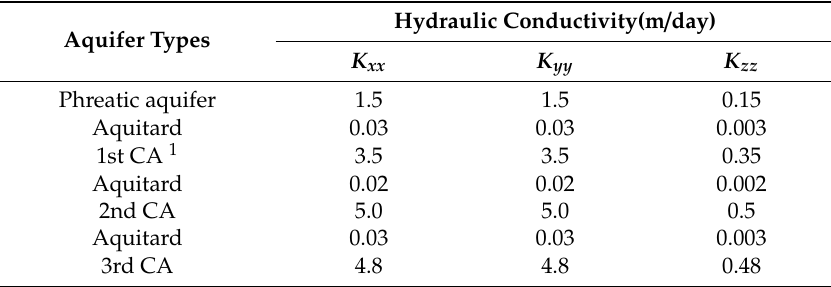
Table 4. Inversion values of hydraulic conductivity for di ff erent